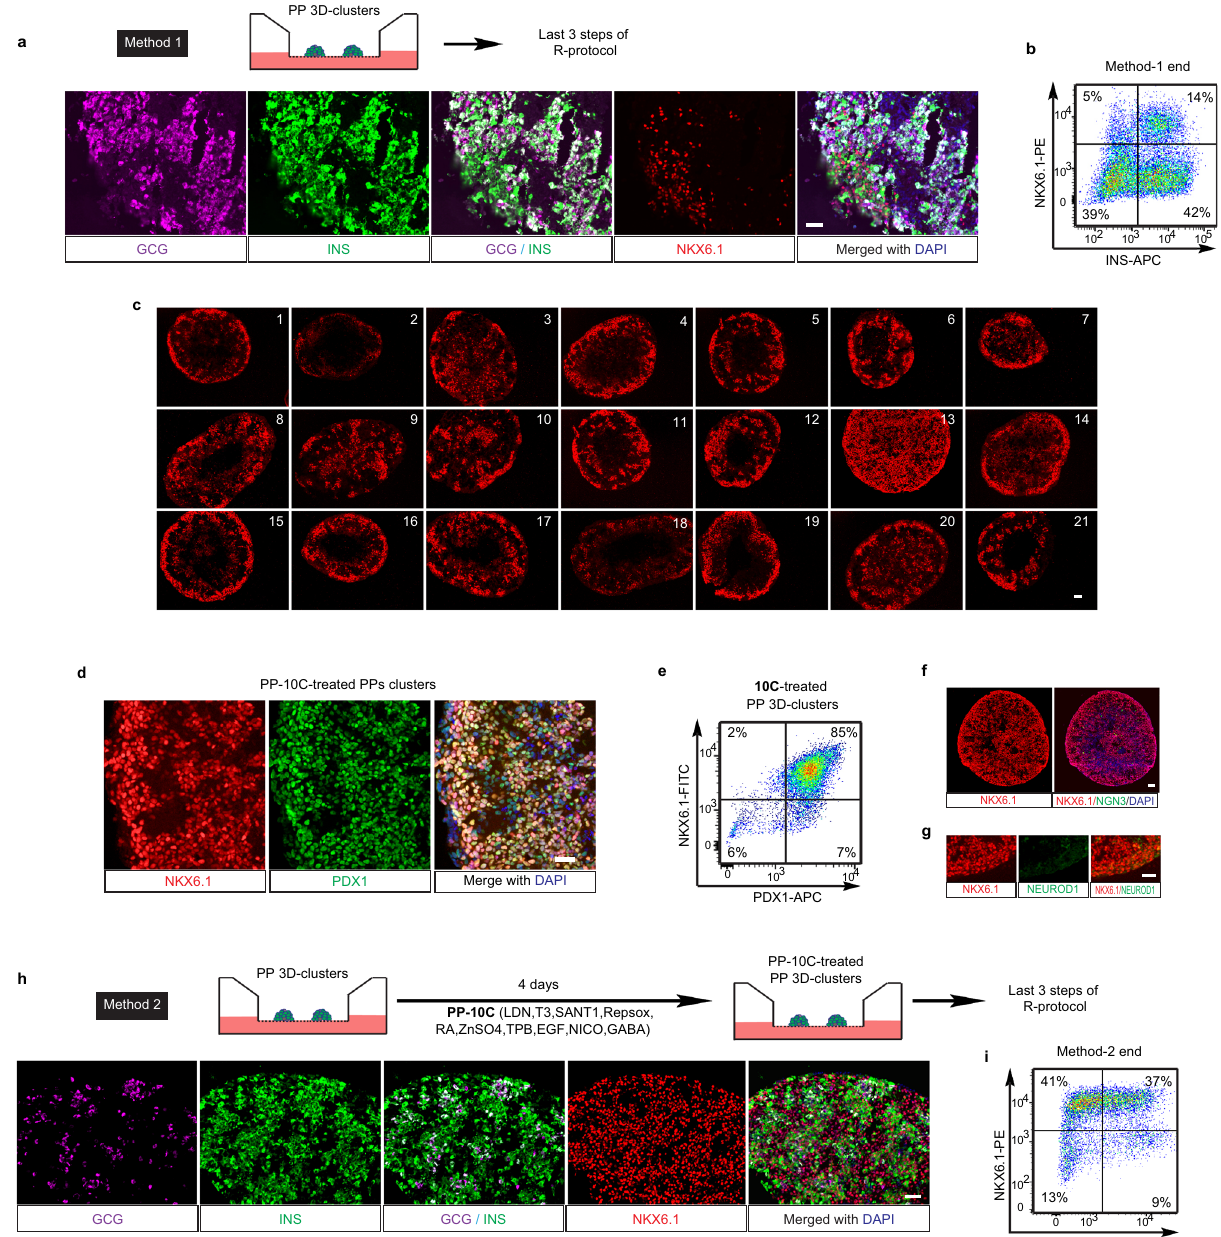
Fig. 2 Ten chemicals poise pancreatic progenitors in 3D clusters. a , b Method 1: H1 cell-derived PP 3D clusters were induced into β -cell stage, using the last three steps of R-protocol. Both immuno fl uorescent staining ( a ) and cell cytometry analysis ( b ) showed that end-stage cell culture comprised high percentage of INS + /NKX6.1 − cells (mainly GCG + /INS + cells) and a low number of β -cells (NKX6.1 + /INS + ). c H1 cell-derived PP 3D clusters were